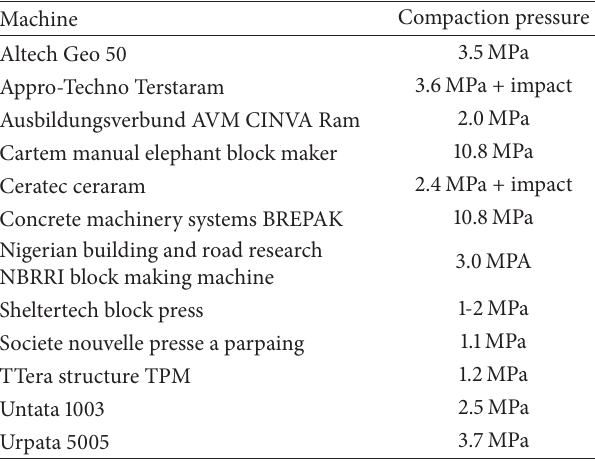
Table 3: Soil characteristics.